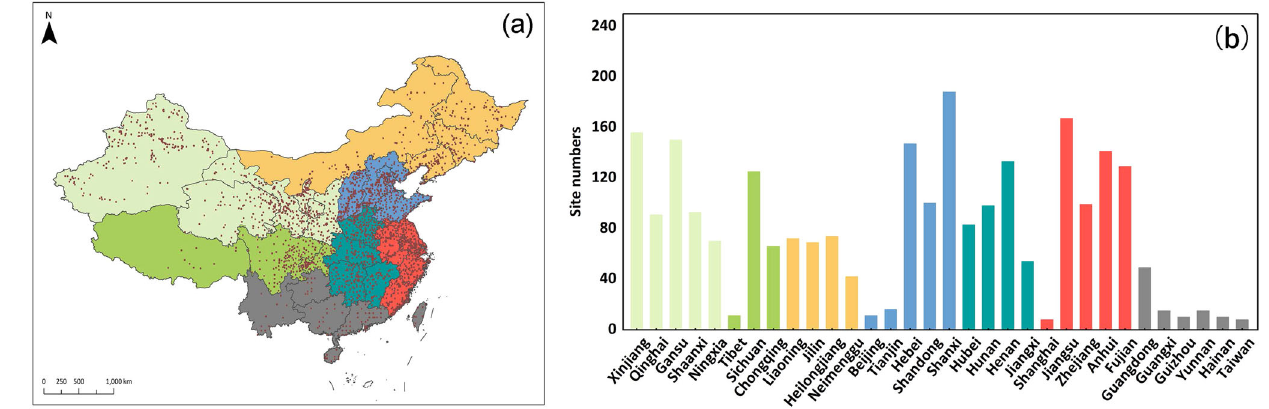
Fig. 1 The distribution of the corrosion stations in China. a The distribution of outdoor corrosion stations; b the amount of outdoor corrosion stations in different provinces.